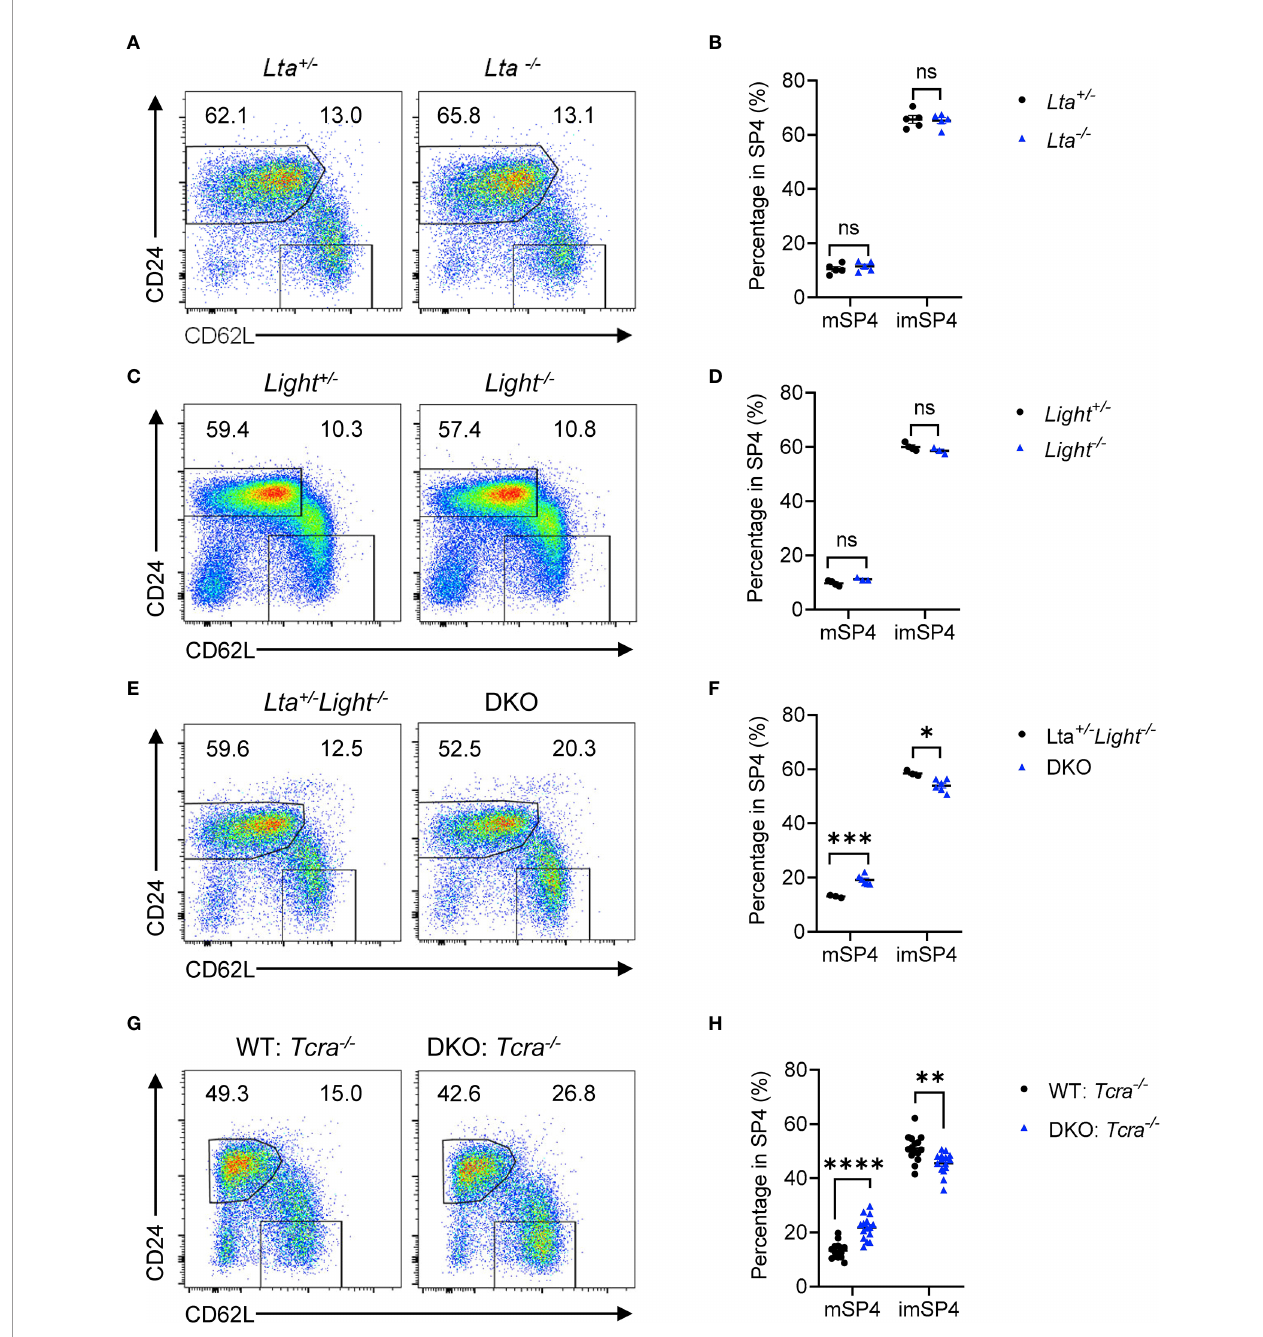
FIGURE 4 | LT and LIGHT expressed on T cells redundantly regulate thymic egress. (A, B) Flow cytometric analysis of SP4 thymocytes in Lta − / − and littermate control mice. (A) Representative dot plots are shown. (B) The graphs display the statistical analysis of the percentage of immature or mature CD4 + SP thymocytes among total SP4 population. Mean ± SEM; n = 5. Data are representative of at least three independent experiments. (C, D) Flow cytometric analysis of SP4 thymocytes in Light − / − and littermate control mice. (C) Representative dot plots are shown. (D) The graphs display the statistical analysis of the percentage of immature or mature CD4 + SP thymocytes among total SP4 population. Mean ± SEM; n = 4 and 3. Data are representative of at least three independent experiments. (E, F) Flow cytometric analysis of SP4 thymocytes in Lta − / − Light − / − and littermate control mice. (E) Representative dot plots are shown. (F) The graphs display the statistical analysis of the percentage of immature or mature CD4 + SP thymocytes among total SP4 population. Mean ± SEM; n = 3 and 6. Data are representative of at least three independent experiments. (G, H) Flow cytometric analysis of thymocytes in bone marrow chimeric mice with de fi ciency of both LT b R ligands in T cells. (G) Representative dot plots of SP4 thymocytes are shown. (H) The graphs display the statistical analysis of the percentage of immature or mature CD4 + SP thymocytes among total SP4 population. Mean ± SEM; n = 15. Data are pooled from three independent experiments. ns, P > 0.05; *P < 0.05; **P < 0.01; ***P < 0.001; ****P < 0.0001 (unpaired Student ’ s t